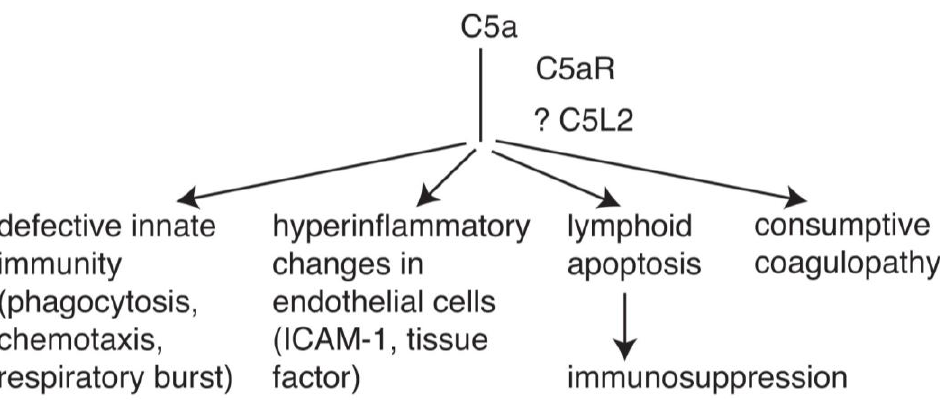
FIGURE 2. C5a generated during sepsis interacts with its receptors C5aR and C5L2. This leads to four major complications: defects in innate immune responses of neutrophils, conversion of endothelial cells to a hyperinflammatory state with increased expression of ICAM-1 and tissue factor, lymphoid cell apoptosis with ensuing immunosuppression, and consumptive coagulopathy. All of these complications can be blocked by in vitro blockade of C5a or its two